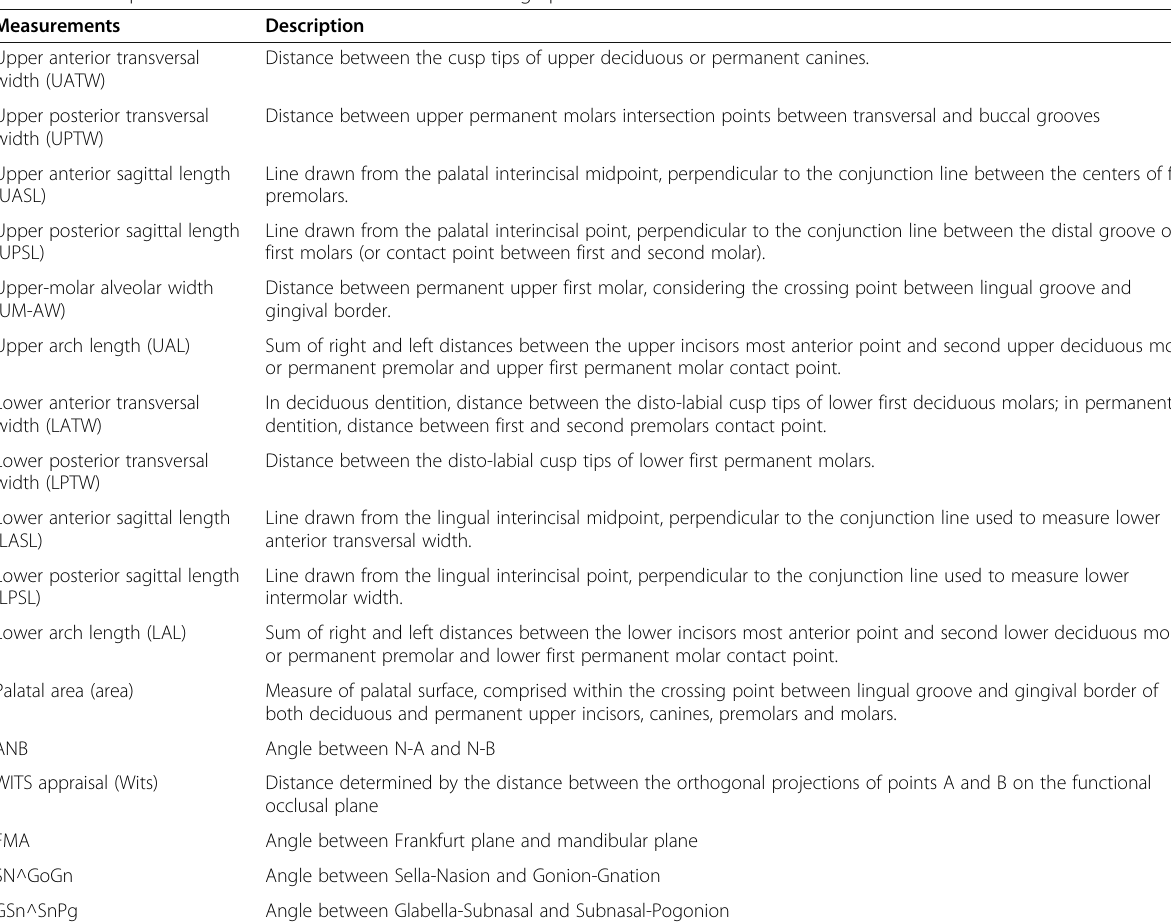
Table 1 Description of the measurements on lateral radiographs and dental